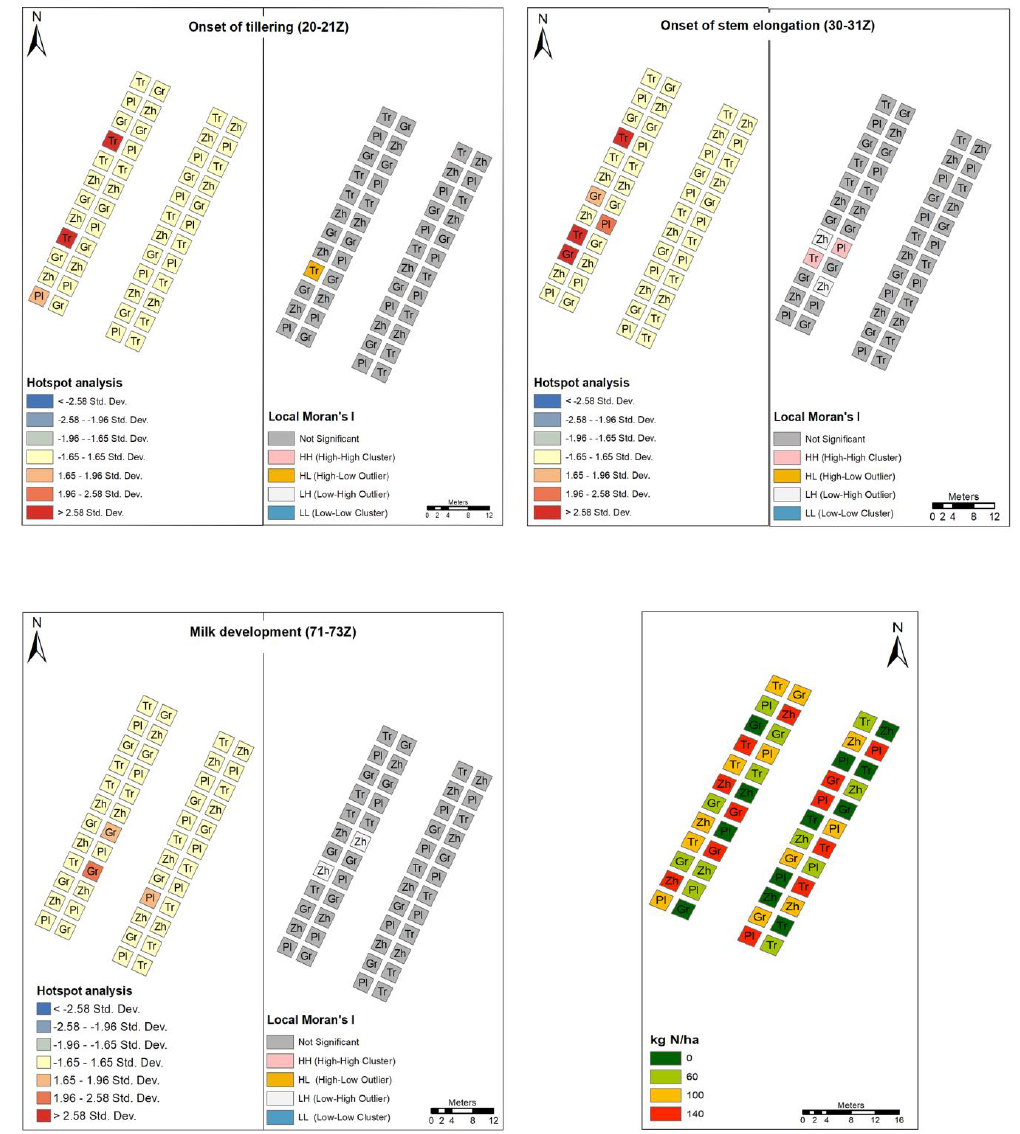
Figure 5. Composite hotspot analysis (Gi z-score) and cluster pattern analysis (local Moran’s I) of disease severity (caused by Pyrenophora teres f. teres and Rhynchosporium secalis ) assessed at different developmental stages of malt barley. A georeferenced arrangement of the experimental area showing the distribution of the cultivar and N-fertilizer treatments is also presented. The abbreviations stand for Gr = Grace, Zh = Zhana, Tr = Traveler and Pl = Planet.